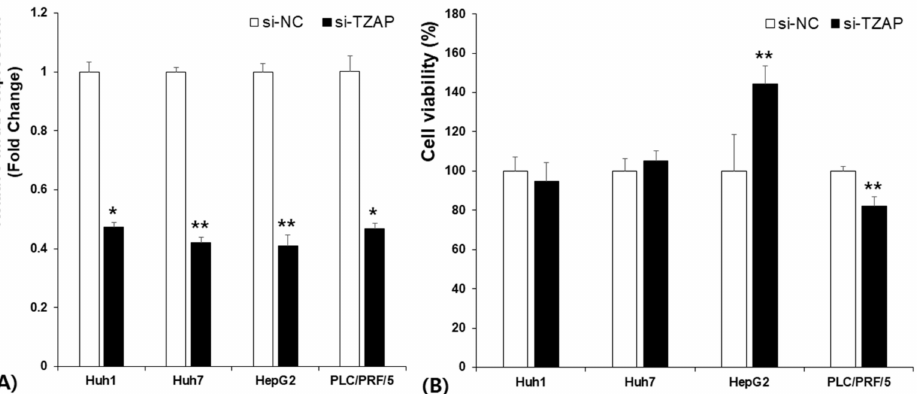
Figure 3. siRNA knockdown of TZAP and cell viability in HCC: ( A ) TZAP expression in Huh1, Huh7, HepG2, and PLC/PRF/5 cells after transfection; and ( B ) cell viability after transfection. * p < 0.05; ** p <